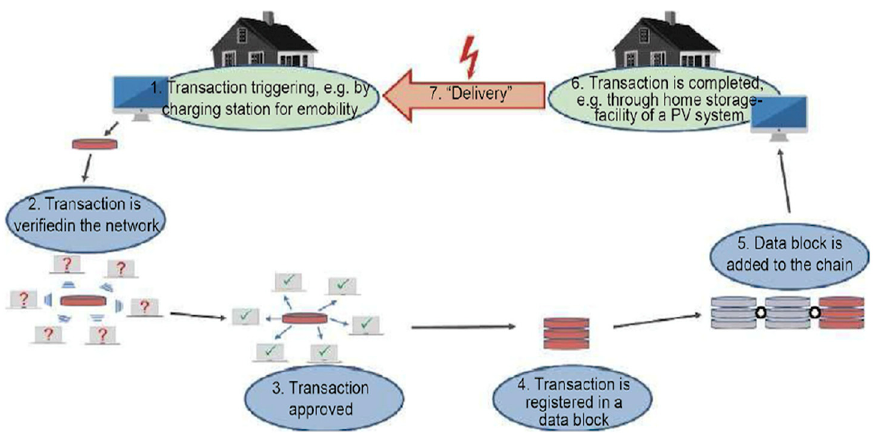
Figure 1. Blockchain-based transaction framework adapted from [20].